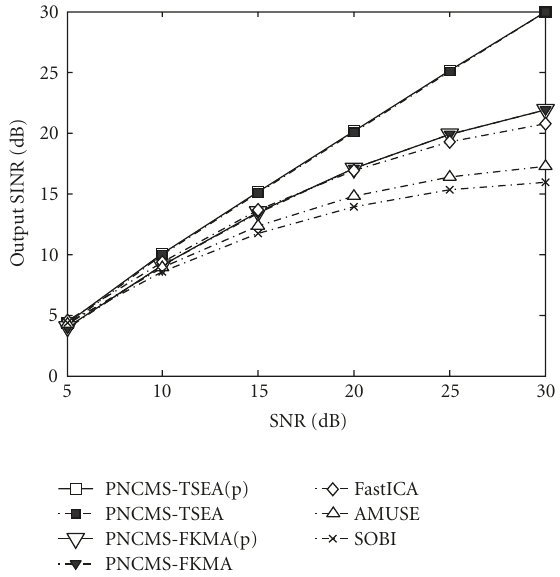
Figure 4: Performance comparison results of Part B (output SINR versus SNR) for A = A 1